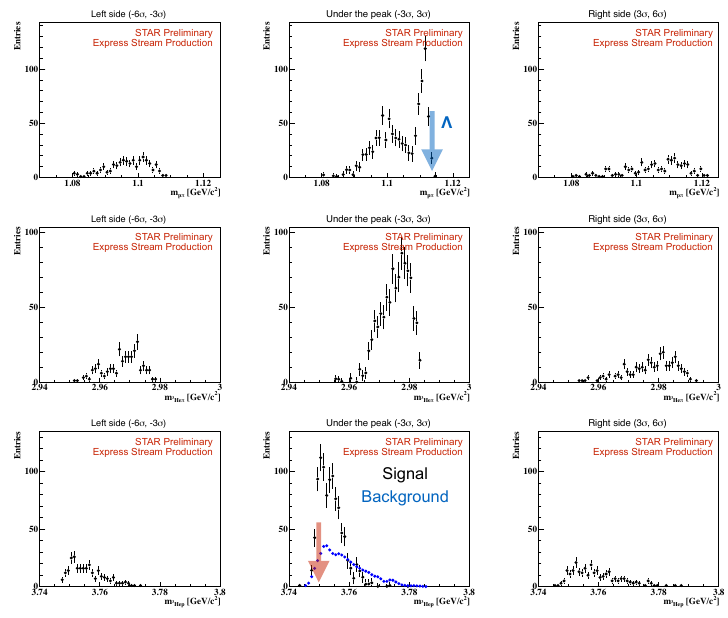
Figure 5. Projections of the Dalitz plots for the decay 4 Λ He → 3 He + p + π − . The complex structure in the signal in the p π projection can be explained as a possible spin e ff ect. In the nucleus-p combination, the signal and the background show di ff erent behavior. There can be seen a hint of two-body 4 Li π − decay ( 4 Li (J P = 2 − ): M = 3.75 GeV / c 2 , σ = 8.7 MeV / c 2